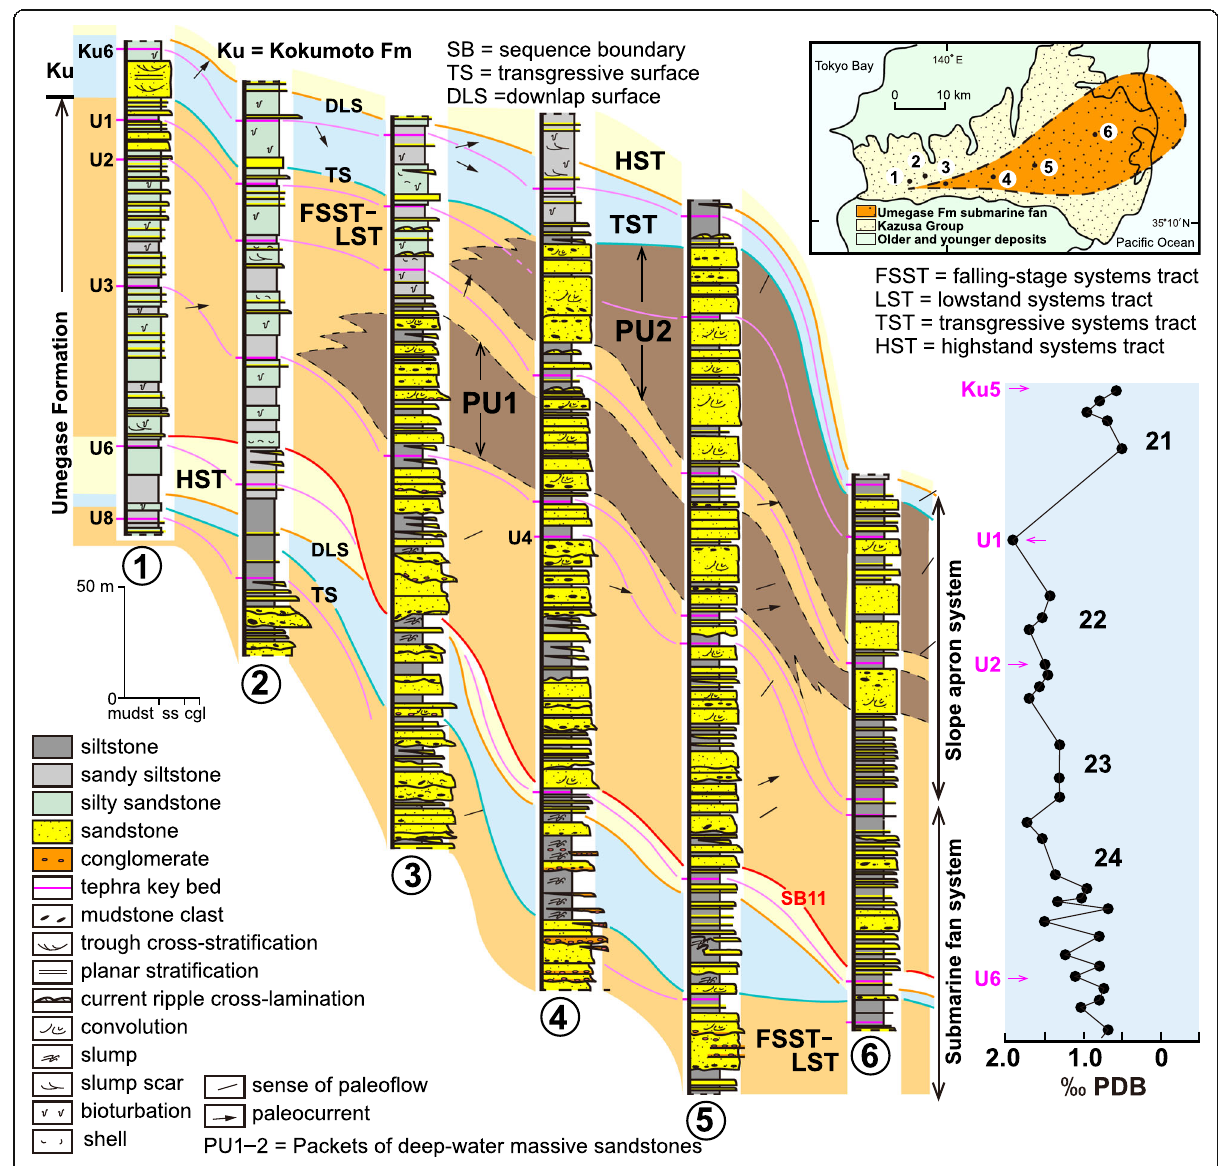
Fig. 3 Stratigraphic cross-section and sequence-stratigraphic classification of the upper Umegase Formation. Modified from Ito (1998). The oxygen isotopic data are from Pickering et al. (1999) and are adjusted to the stratigraphic section 6. The inset map shows the locations of the measured sections and the distribution of the submarine-fan system. U8 – Ku5 denotes the coding of tephra key beds. SB11 is a sequence boundary defined by Ito and Katsura (1992). See Fig. S1 for the stratigraphic position of SB11 within the Kazusa